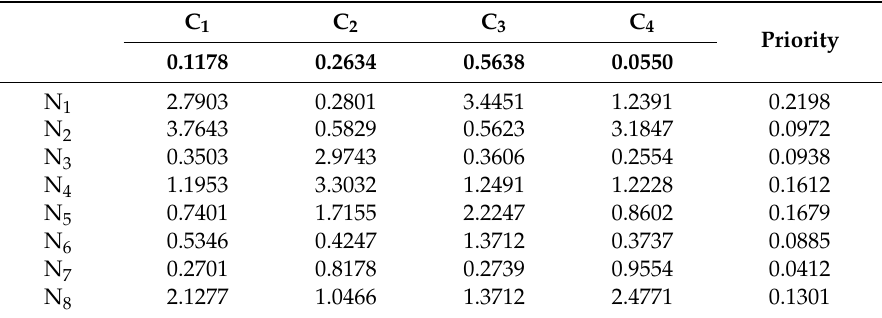
Table 9. Sequence list of cognitive behavioral needs